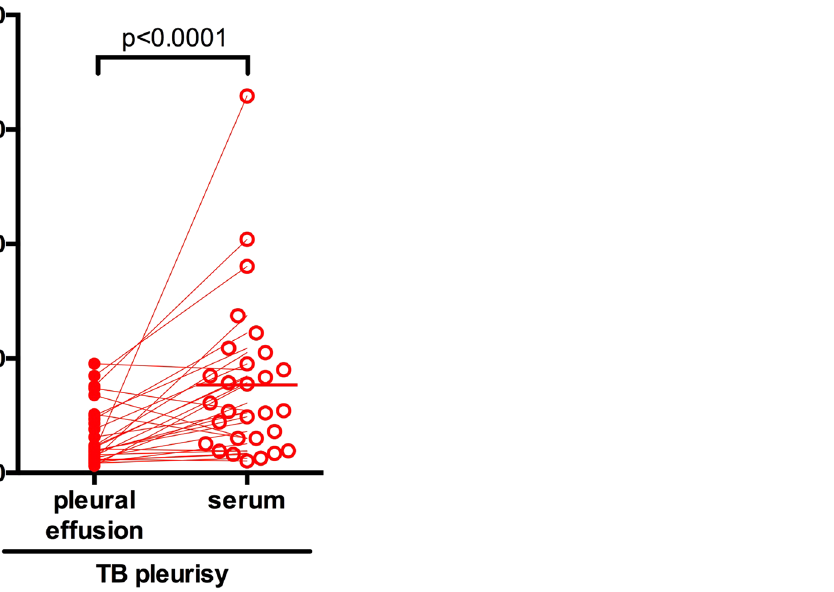
Figure 2. Serum and pleural concentrations of sCD206 in patients with tuberculous (TB) pleurisy. Unfilled and filled circle represent pleural fluids and serum, respectively. P values were determined by the Wilcoxon matched-pairs signed rank